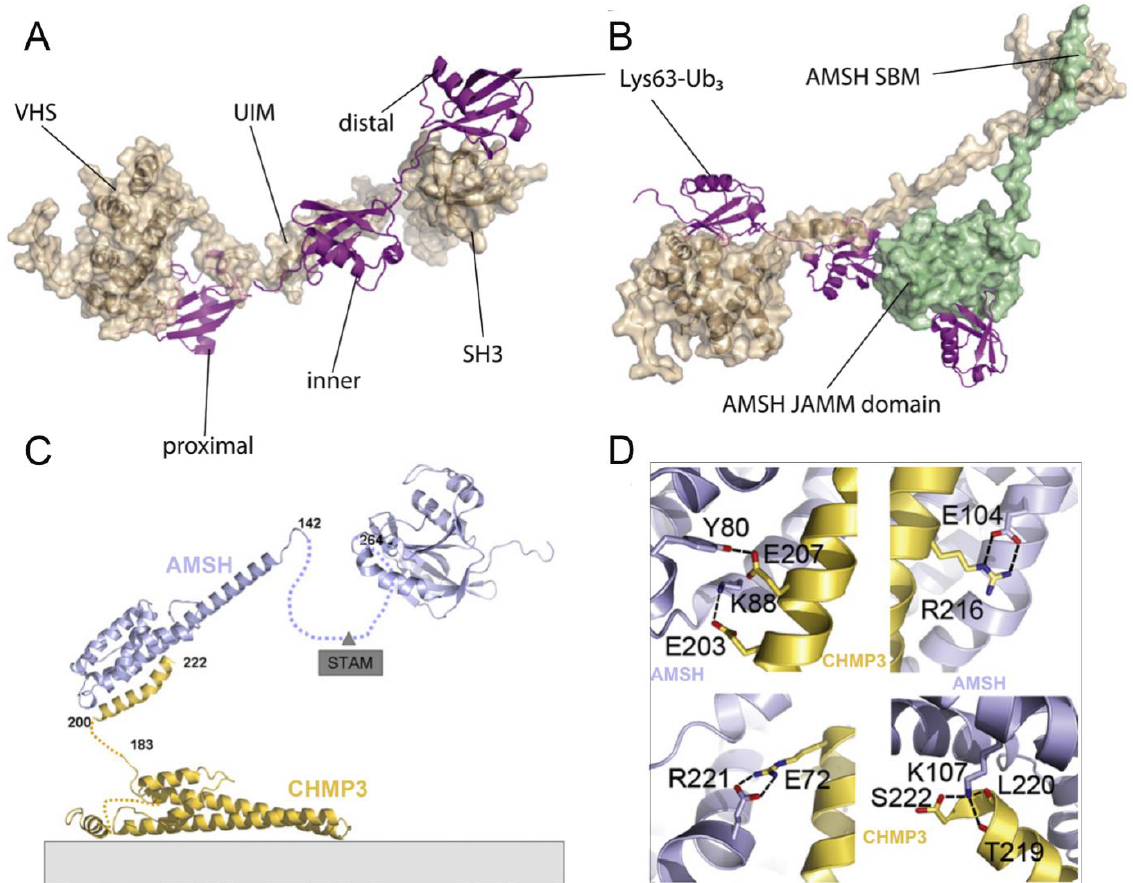
Figure 4. ( A , B ) A possible structural model for AMSH-STAM-ubiquitin complex. The AMSH, STAM, and ubiquitin are colored green, sand, and fuchsia, respectively. ( C ) The molecular model of AMSH in complex with CHMP3. ( D ) Close-up of the CHMP3 – AMSH interactions group (PDB ID: 2XZE). The AMSH and CHMP3 are colored light blue and yellow, respectively. Hydrogen bonds and salt bridges along the CHMP3 helical segment mediate high-affinity interaction. Panels A, B and C , D are adapted with permission from [79,82], respectively. Copyright 2016 Elsevier, and copyright 2011 Elsevier.